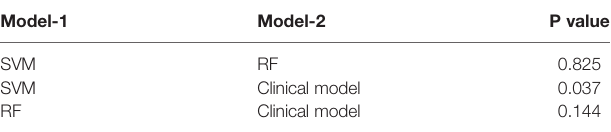
TABLE 3 | DeLong test within different prediction